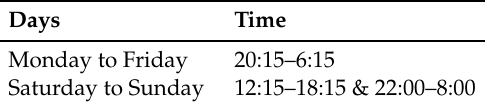
Table 1. Possible times of electric heating.